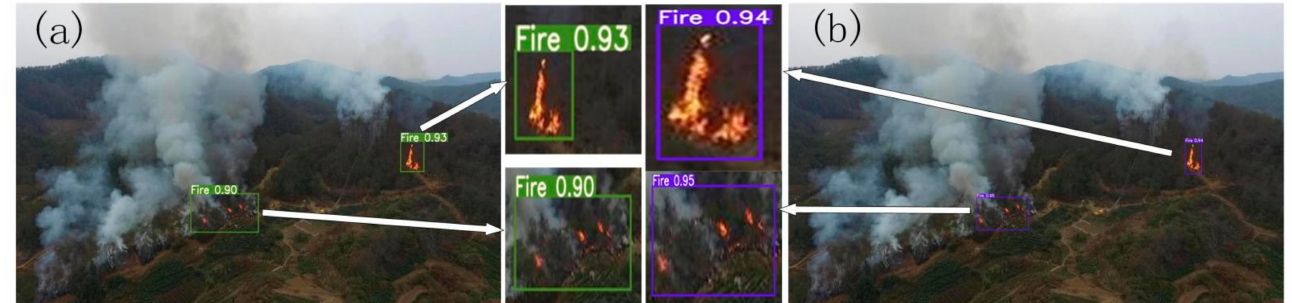
Figure 5. Fire detection results of YOLOv5 and the dynamic convolution YOLOv5. ( a ) YOLOv5. ( b ) Dynamic convolution YOLOv5.